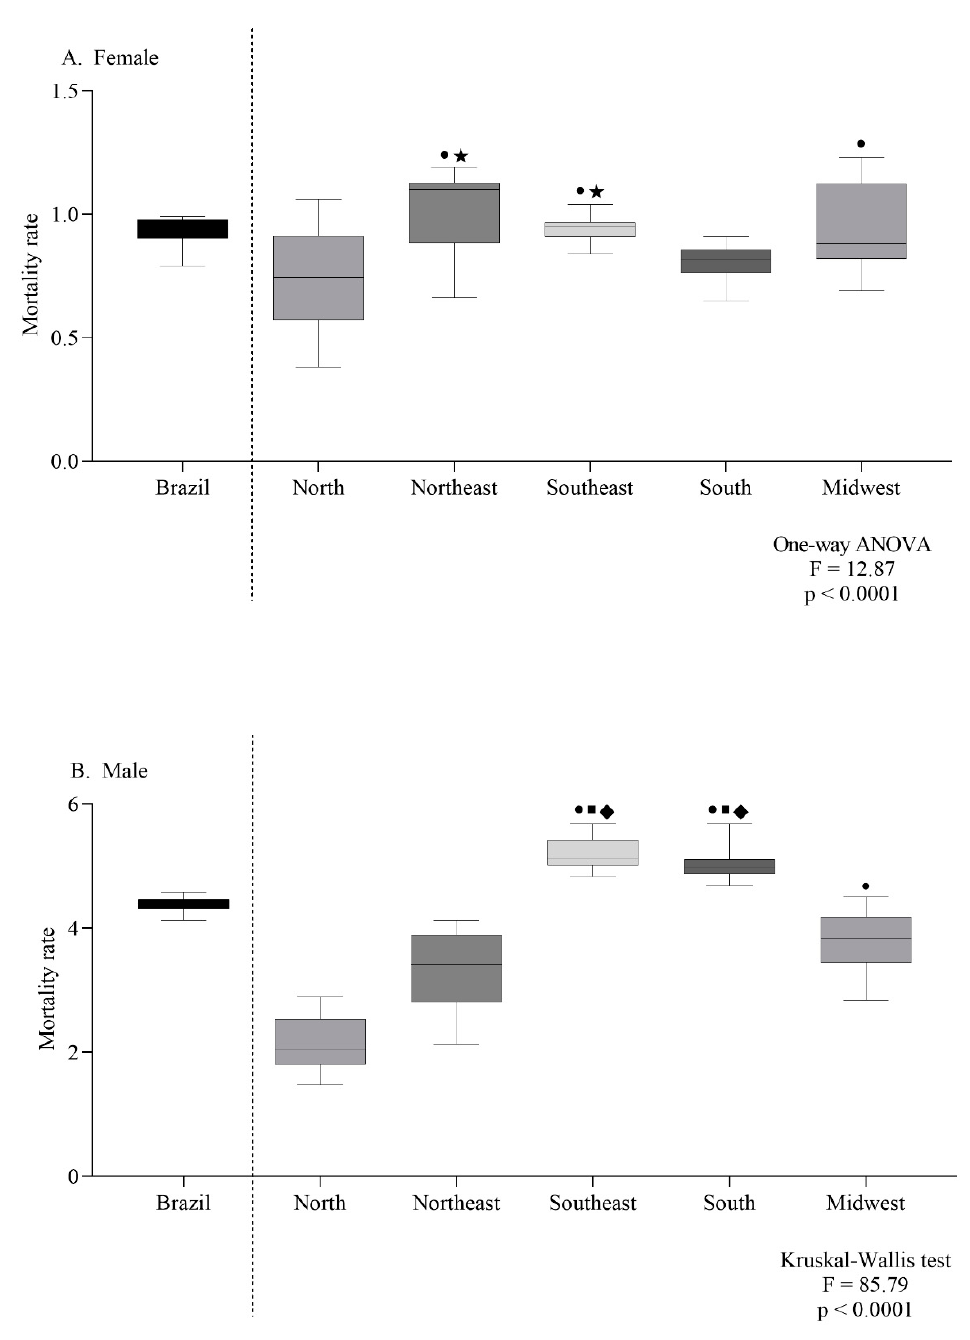
Figure 4. Mortality rate for every 100,000 inhabitants per sex (female ( A ) or male ( B )) according to geographic region ( A , B ). Symbols indicate significant differences between regions: north ● ; northeast ■ ; midwest ◆ ; south ★ ( p < 0.05, Dunn’s test).